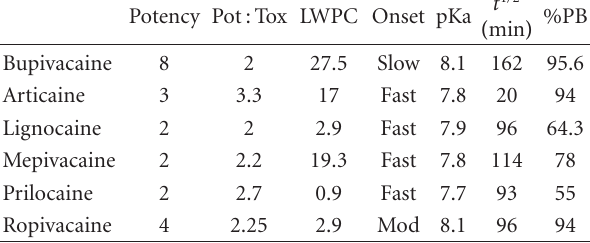
Table 1: Pharmacology of common local anesthetics. Potency is relative. Potency: toxicity ratio is a useful evaluation to consider, articaine has the best ratio making it clinically e ffi cacious as well as safe. %PB = protein